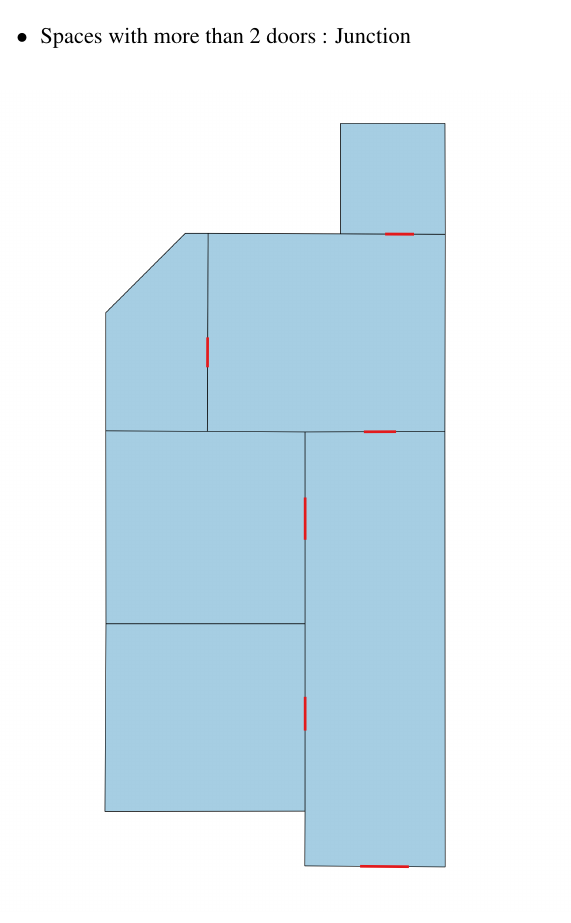
Figure 7. Output after polygon and topology